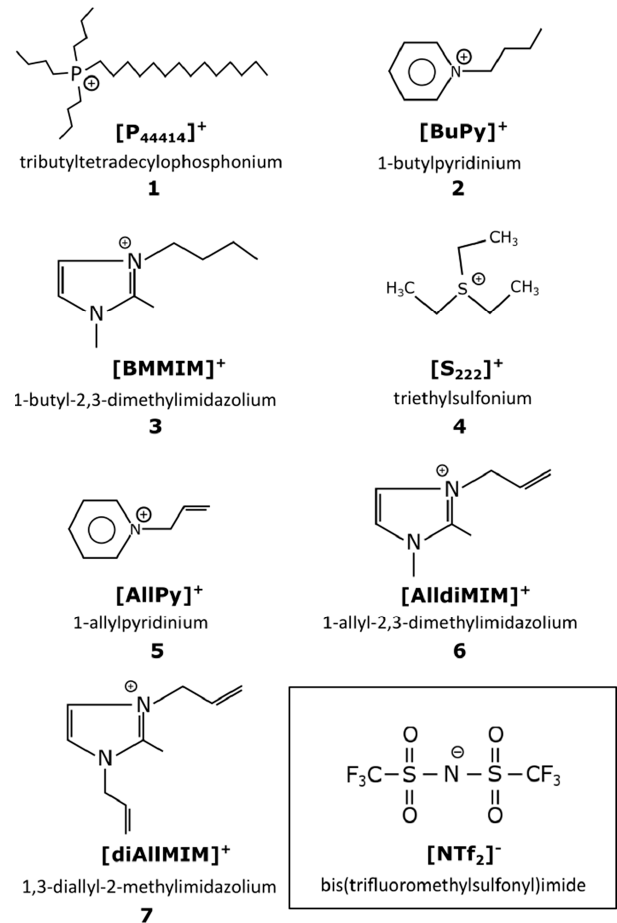
Figure 1. Schematic representation of ionic liquids used as solvent for catalyst in hydrosilylation reaction (1–7). All ILs have the same anion: bis(trifluoromethylsulfonyl)imide—[NTf 2 ] − (highlighted by a frame).